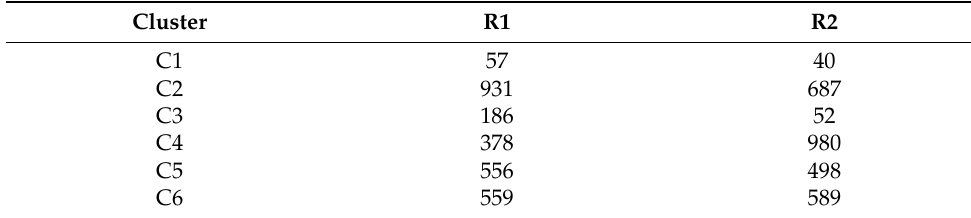
Table 1. Cell populations in each cluster identified in R1 and